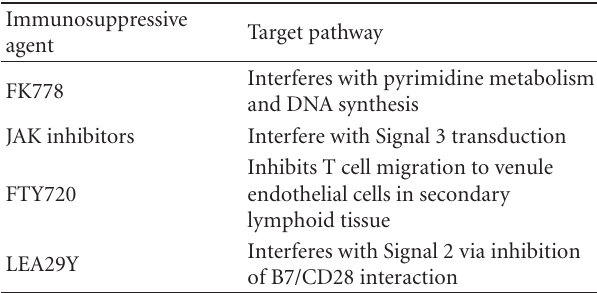
Table 4: Investigational immunosuppressive agents in liver trans-